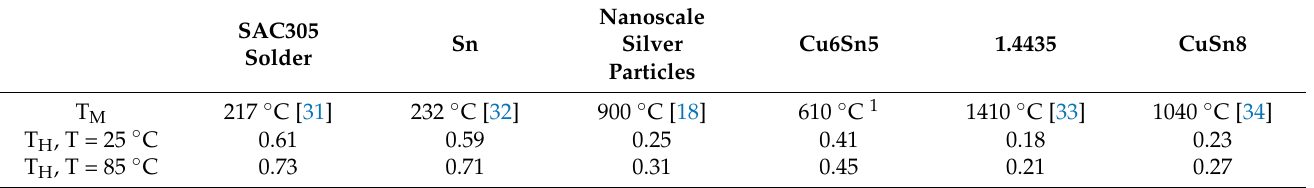
Table 3. Homologous temperature for the used